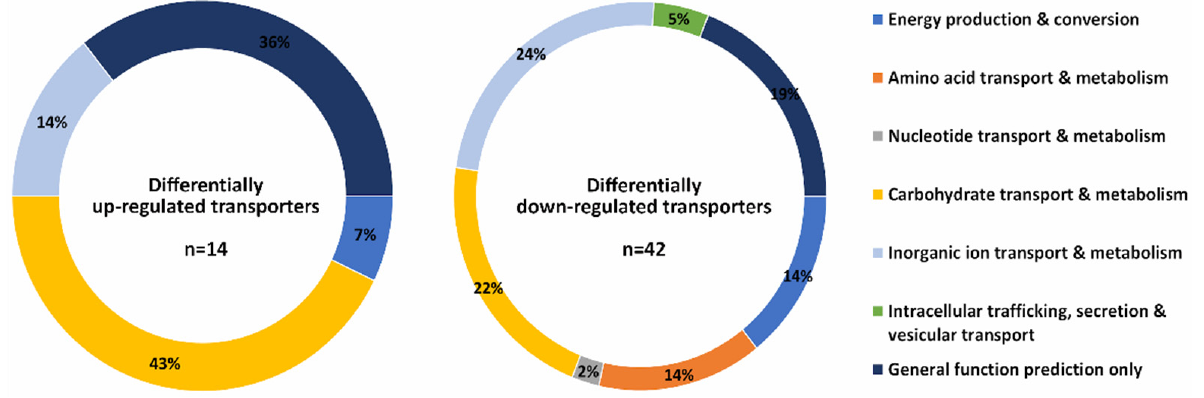
Figure 2. Proportion of the up- and downregulated transporter genes of M. lusitanicus grown anaerobically compared to those after aerobic culturing of the fungus.